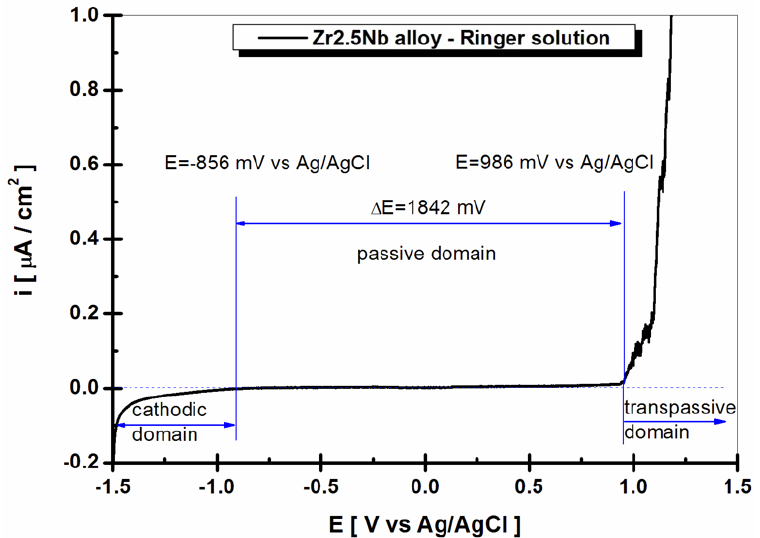
Figure 6. Potentiodynamic polarization diagram for Zr2.5Nb alloy immersed in Ringer’s solution plotted with a potential scanning rate of 3 mV/s.